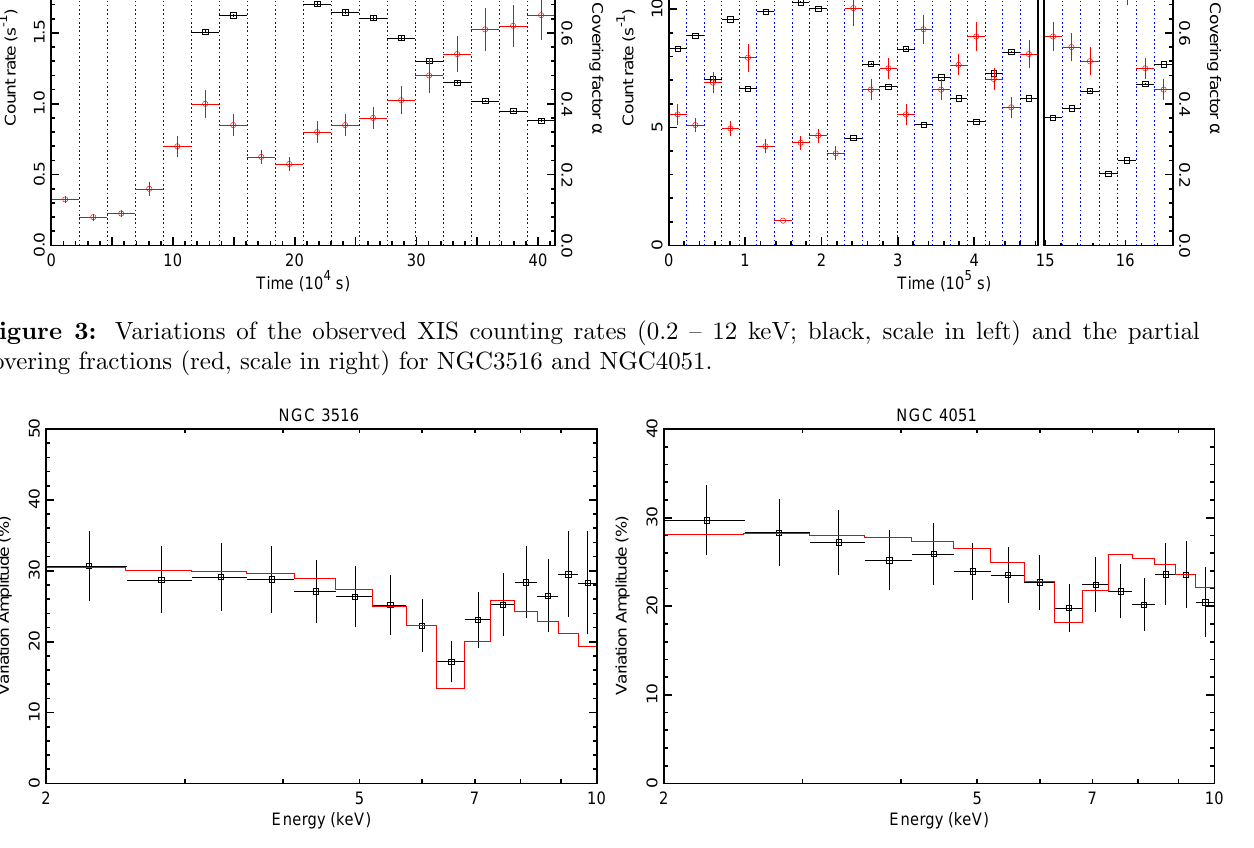
Figure 4: RMS (Root-Mean-Square) spectra for NGC3516 and NGC4051. Black points are calculated from the data, and red-histograms are calculated from the best-fit spectral models for the time-sequence spectra. examples of the 22 RMS spectra in figure 4. The small variability of the iron line energy band is successfully explained by the VPC